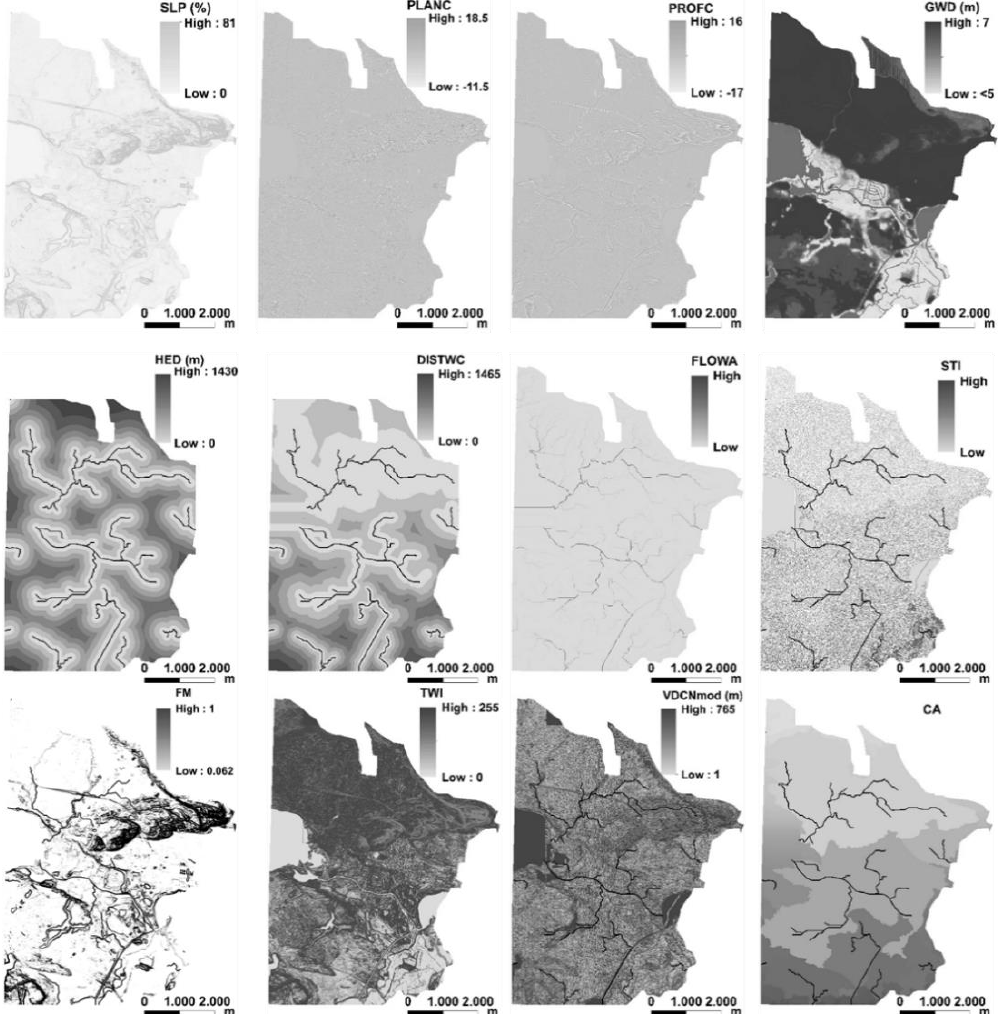
Figure 4. Geomorphometric parameter derived from the LiDAR-DEM and related data for the study area. SLP is slope, PLANC is curvature surfaces or planar curvature, PROFC is profile curvature, GWD is ground water depth, HED is hydrography Euclidian distance, DISTWC is distance to nearest watercourse, FLOWA is flow accumulation, STI is sediment transport index, FM is fuzzy membership function, TWI is compound topographic index (SAGA wetness index), VDCNmod is modified vertical distance to channel network, CA is catchment area.